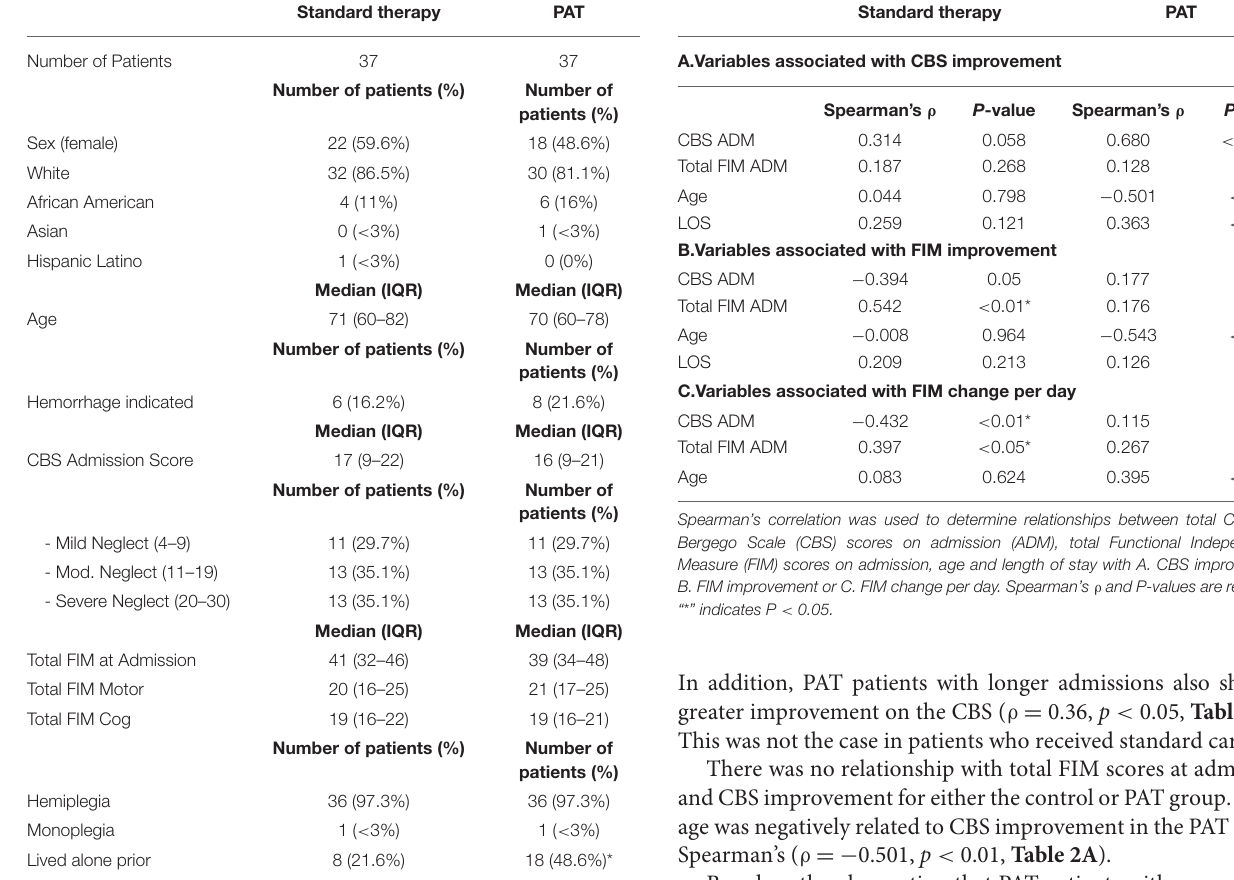
TABLE 2 | Variables associated with improvement outcomes in patients who did and did not receive Prism Adaptation Treatment (PAT). Standard